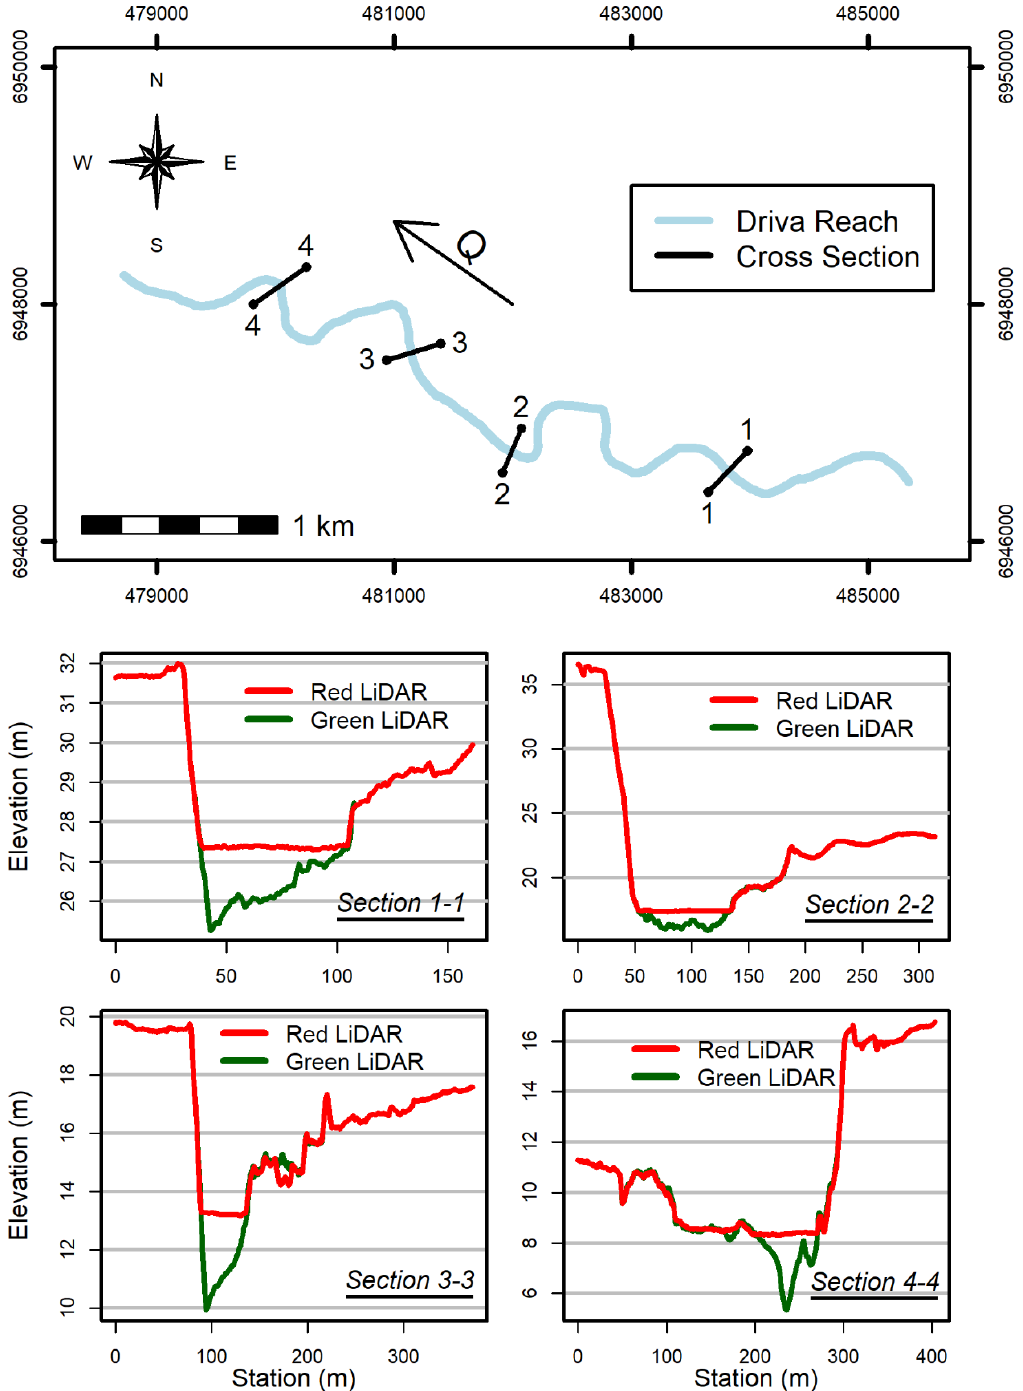
Figure 2. Visual comparison of the LiDAR terrain models for Driva site.